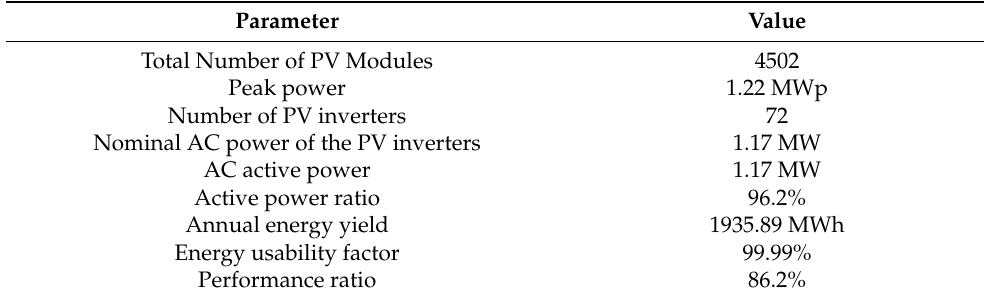
Table 3. Characteristics of the PV system.